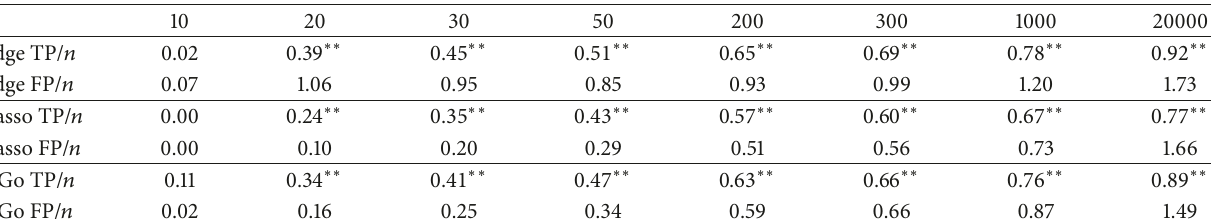
Table 3: Unconditioned transfer entropy network: comparison between fraction of true positive (TP/ 𝑛 ) and fraction of false positive (FP/ 𝑛 ) .